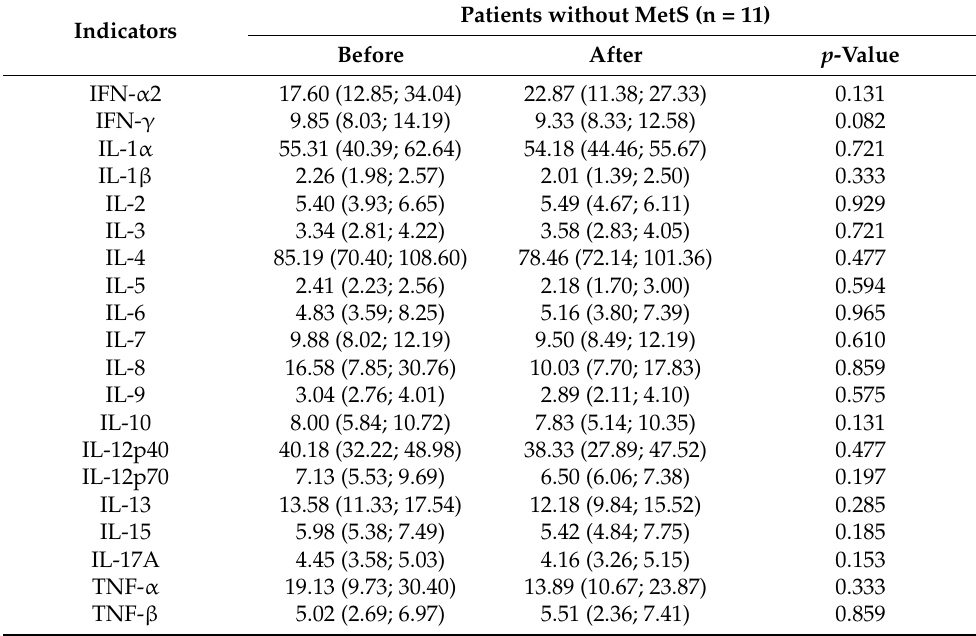
Table 5. Serum concentrations of the cytokines (pg/mL) in patients without MetS during 6 weeks of aripiprazole therapy, Me (Q1; Q3). Patients without MetS (n = 11) Indicators Before